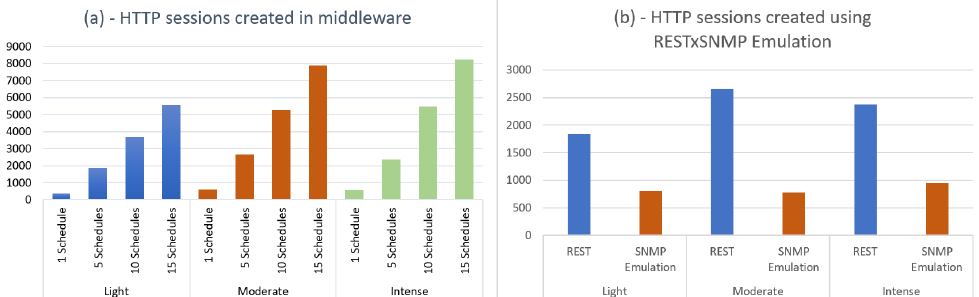
Figure 7. HTTP sessions opened by the Middleware using ( a ) REST architectural style; ( b ) REST with SNMP